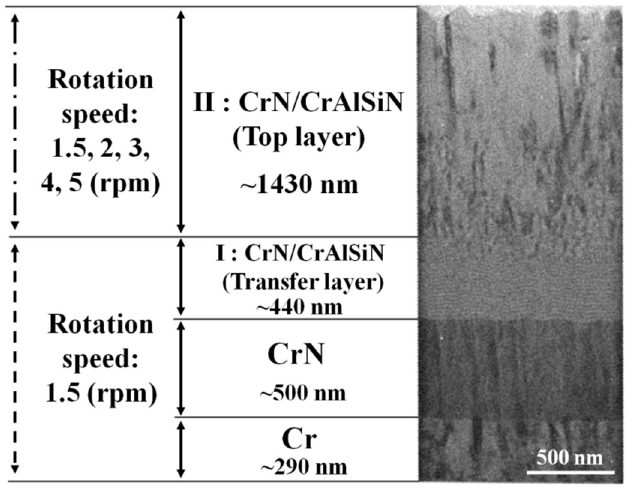
Figure 1. Schematic illustration and TEM image showing the coating structure. Table 1. Experiment parameters used in HiPIMS deposition of CrN / CrAlSiN multilayer coatings.